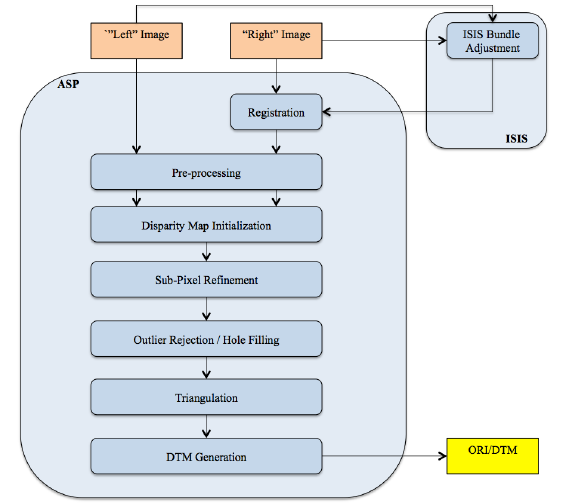
Figure 1. Flow diagram of the original ASP processing chain.